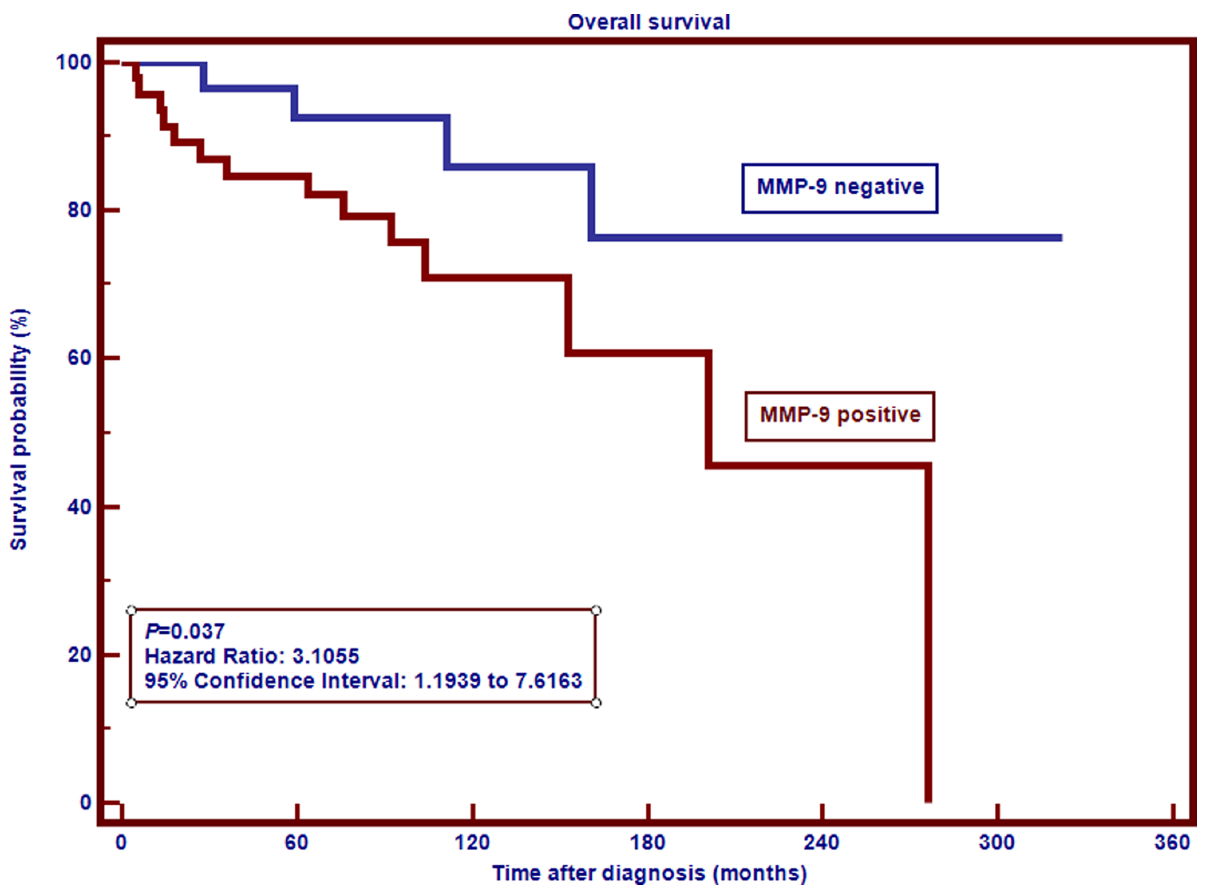
Figure 2. Overall survival probability of 78 patients diagnosed with classical Hodgkin lymphoma between 15 and 45 years of age according to MMP9 expression.